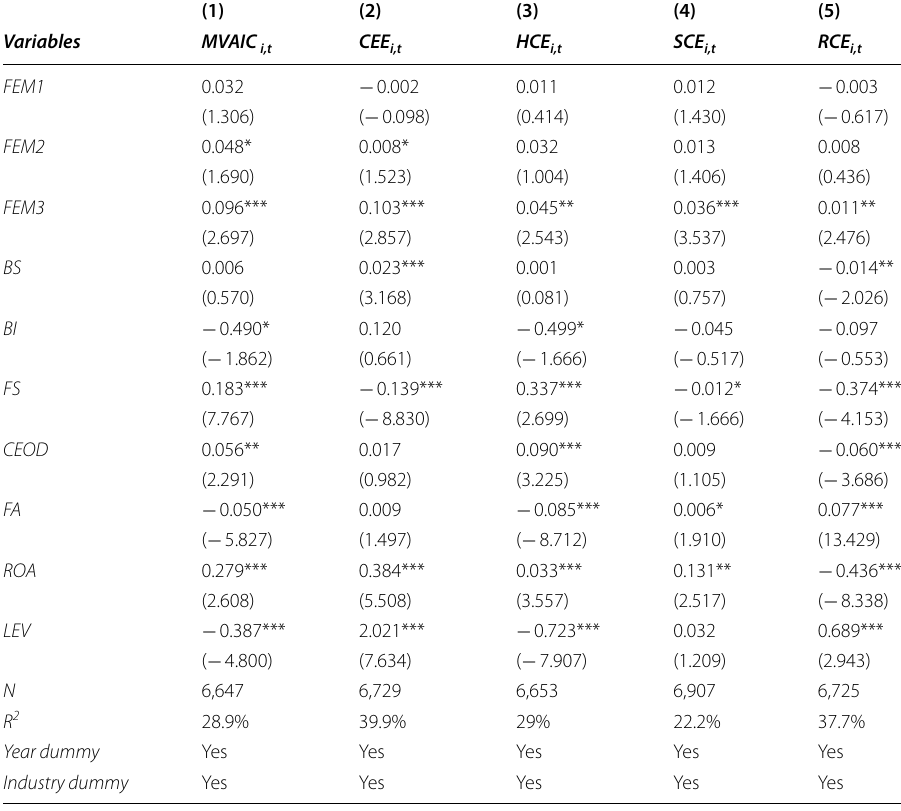
The t-values are given in parentheses. ***, **, and * denotes significance at 1%, 5%, and 10%, respectively. Variable definitions are provided in Table